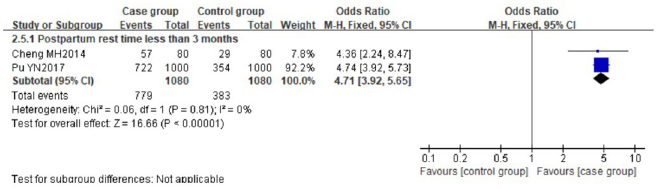
Fig 6. Forest plot comparing the pooled risk of postpartum rest time less than 3 months.